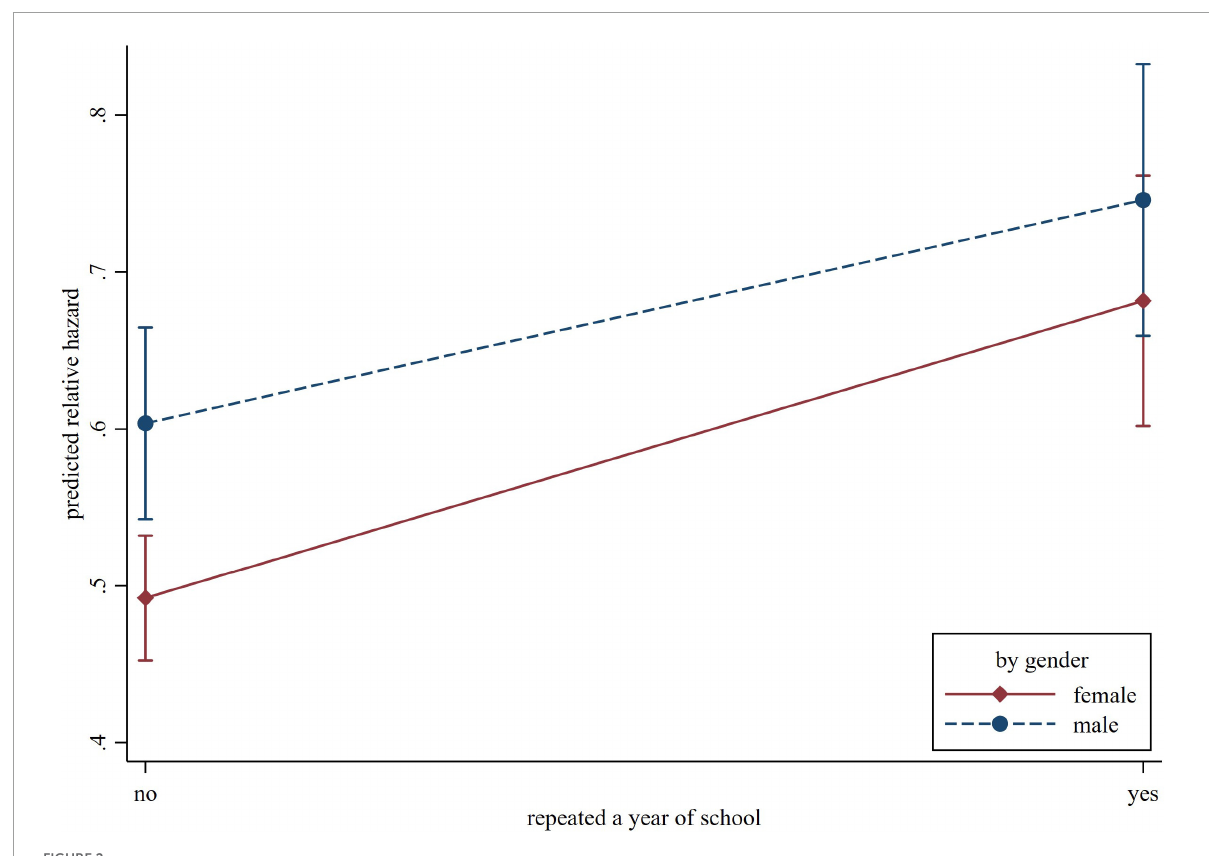
FIGURE2 The predicted relative hazard of cognitive impairment concerning repeating a year of school, by